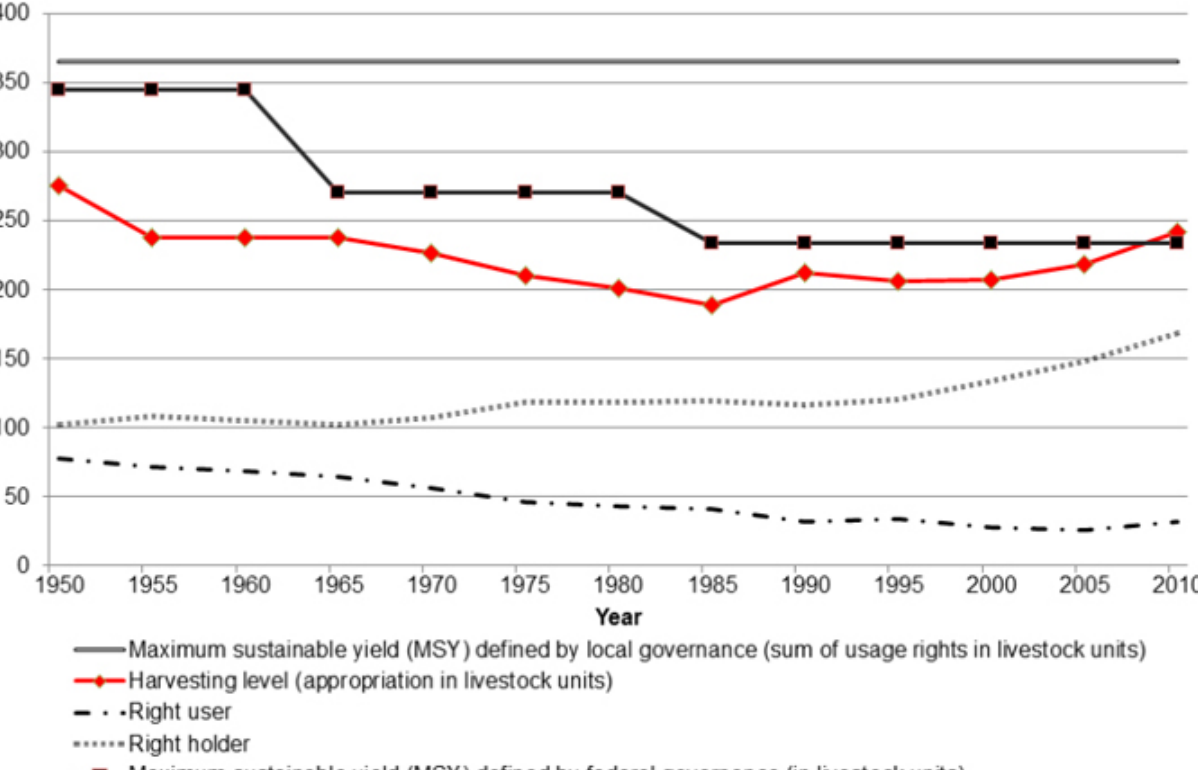
Fig. 4 .Changes in maximum sustainable yield, constant appropriation, number of rights users, and number of rights holders in the Scheidegg